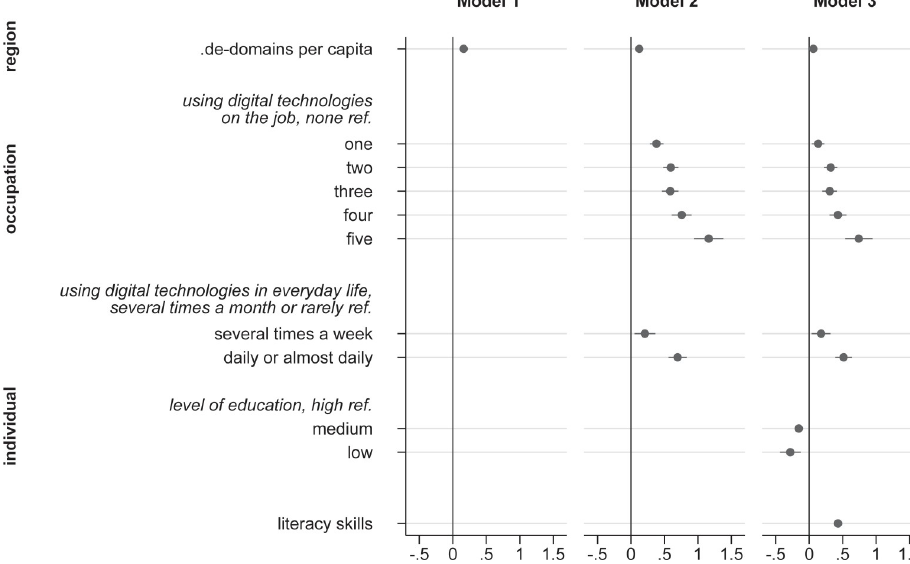
Fig 4. ICT skills regressed on individual and contextual factors (NEPS). (A) Control variables: gender, age, migration. (B) Continuous variables standardized, cluster robust standard errors, 95% confidence intervals. (C) NEPS starting cohort 6 2012/13, N(individuals) 2,786, N(regions) 259.